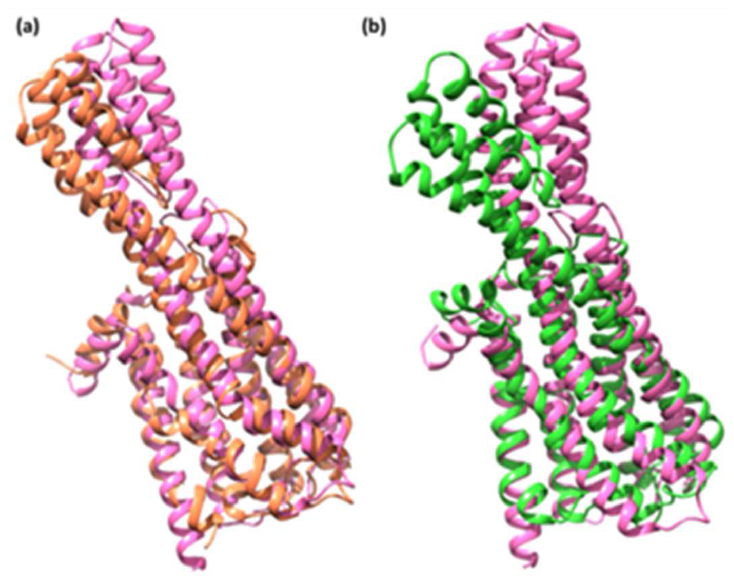
Figure 7. Superimposed structures of ( a ) unbounded serotonin (pink) and serotonin after simulation (orange) for BarS and ( b ) serotonin after simulation (green) for BarCS. (orange) for BarS and ( b ) serotonin after simulation (green) for BarCS.